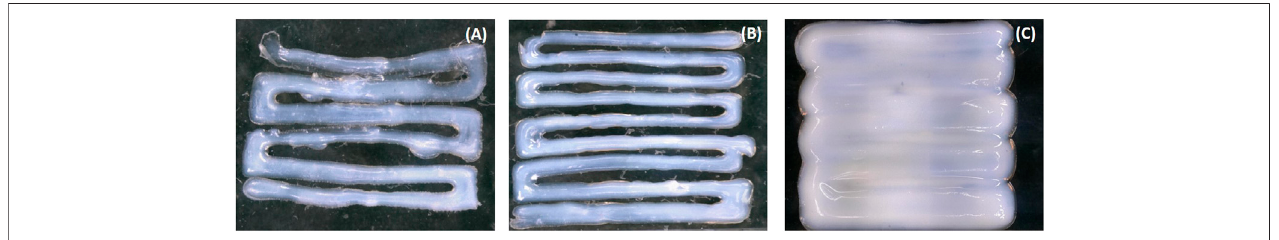
Frontiers in Bioengineering and Biotechnology |